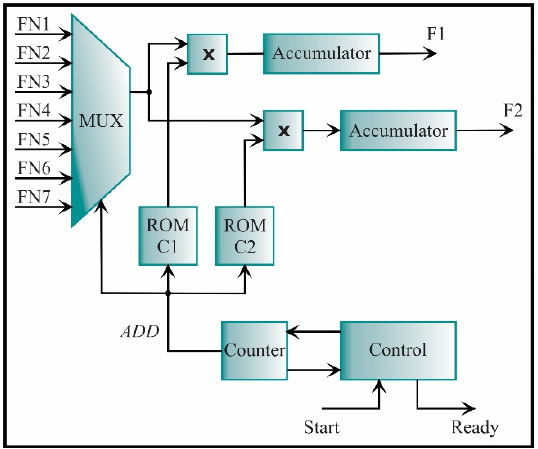
Figure 22. The architecture of the processing core for computing the feature extraction.